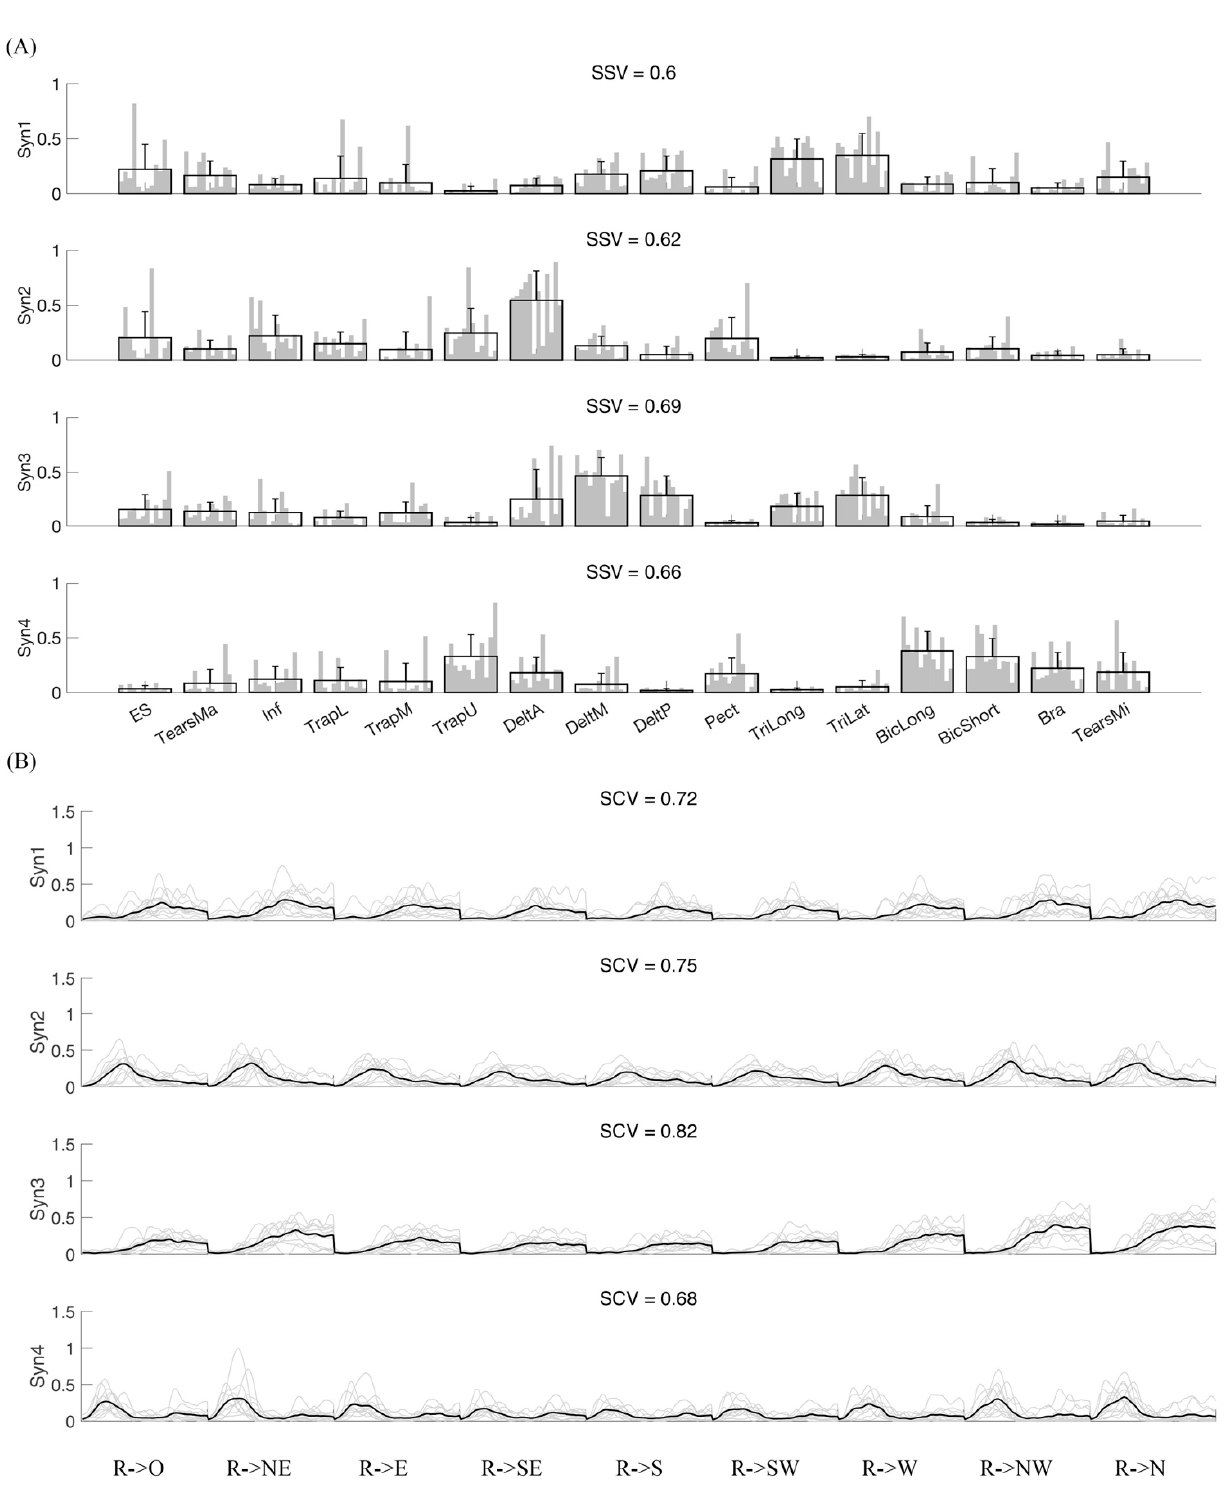
Figure 8. Inter-subject similarity analysis. ( A ) Synergy vectors similarity. Four synergies were extracted from each repetition of each subject. We then averaged the synergies matched across repetitions. Then, we further matched the synergies among subjects. Corresponding activation coefficients were also rearranged. Each subplot shows synergy vectors across subjects. Gray bars indicate different subjects, and the black bar for each muscle indicates group mean and standard deviation. SSV is the average similarity of synergy vectors among subjects. Panel ( B ) shows activation coefficients (AC) similarity. Four ACs corresponding to four synergies were extracted from each repetition. The gray line is the AC from each subject, and the black line is the mean level across subjects. SCV is the mean similarity of activation coefficients across subjects.